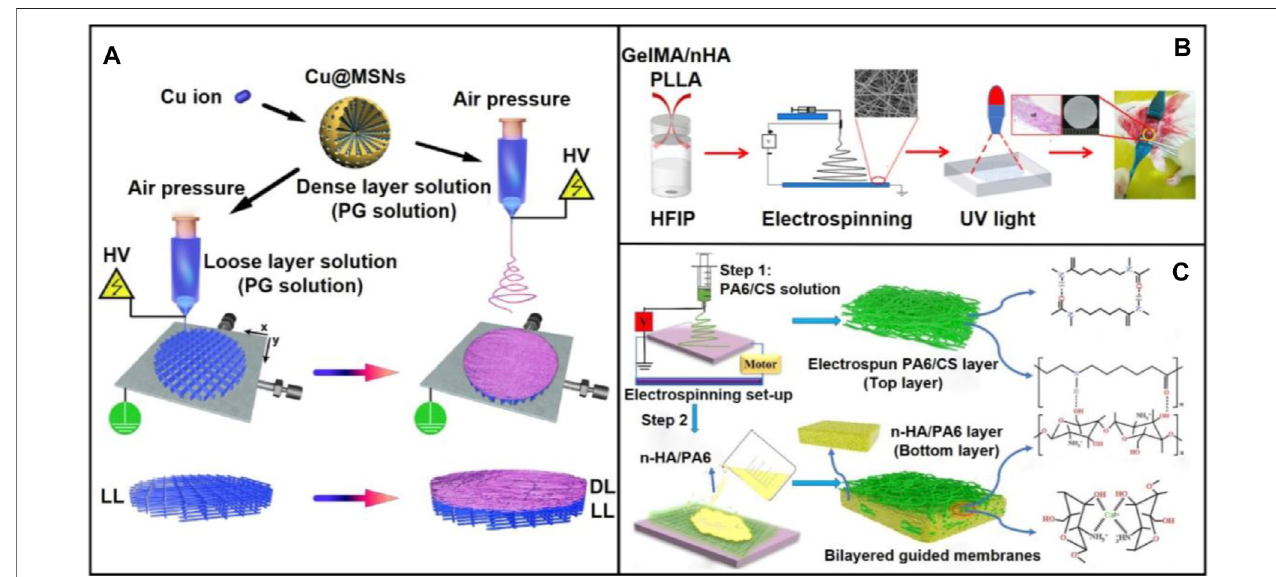
FIGURE 4 | (A) Schematic diagram showing the preparation process and application scenario of the bi-layered electrowritten PLGA/gelatin-Cu@MSNs scaffold. Thebi-layeredPLGA/gelatin-Cu@MSNsGBRscaffoldwasfabricatedusingasingleSEWprinterthroughafaciletwo-stepprocedure.Thebi-layeredcompositescaffold, consisting of a loose and porous SEW layer and a dense and compact SES layer, was prepared by depositing dense layer nano fi bers onto the preprinted loose layer scaffold. Reproduced with permission (Lian et al., 2020). Copyright 2020, Acta Materialia Inc. (Elsevier). (B) Schematic illustration showing the fabrication a biomimetic membrane consisting of GelMA/n-HA/PLA and its use for enhanced bone regeneration. Reproduced with permission (Li et al., 2020). Copyright 2020, AmericanChemicalSociety. (C) Schematicdiagramshowingthepreparationofbilayeredguidedmembraneswithpolyamide-6/chitosannano fi berasthetoplayerwhile the n-HA/polyamide-6 fi lm as the bottom layer. Reproduced with permission (Niu et al., 2021). Copyright 2021, Elsevier.